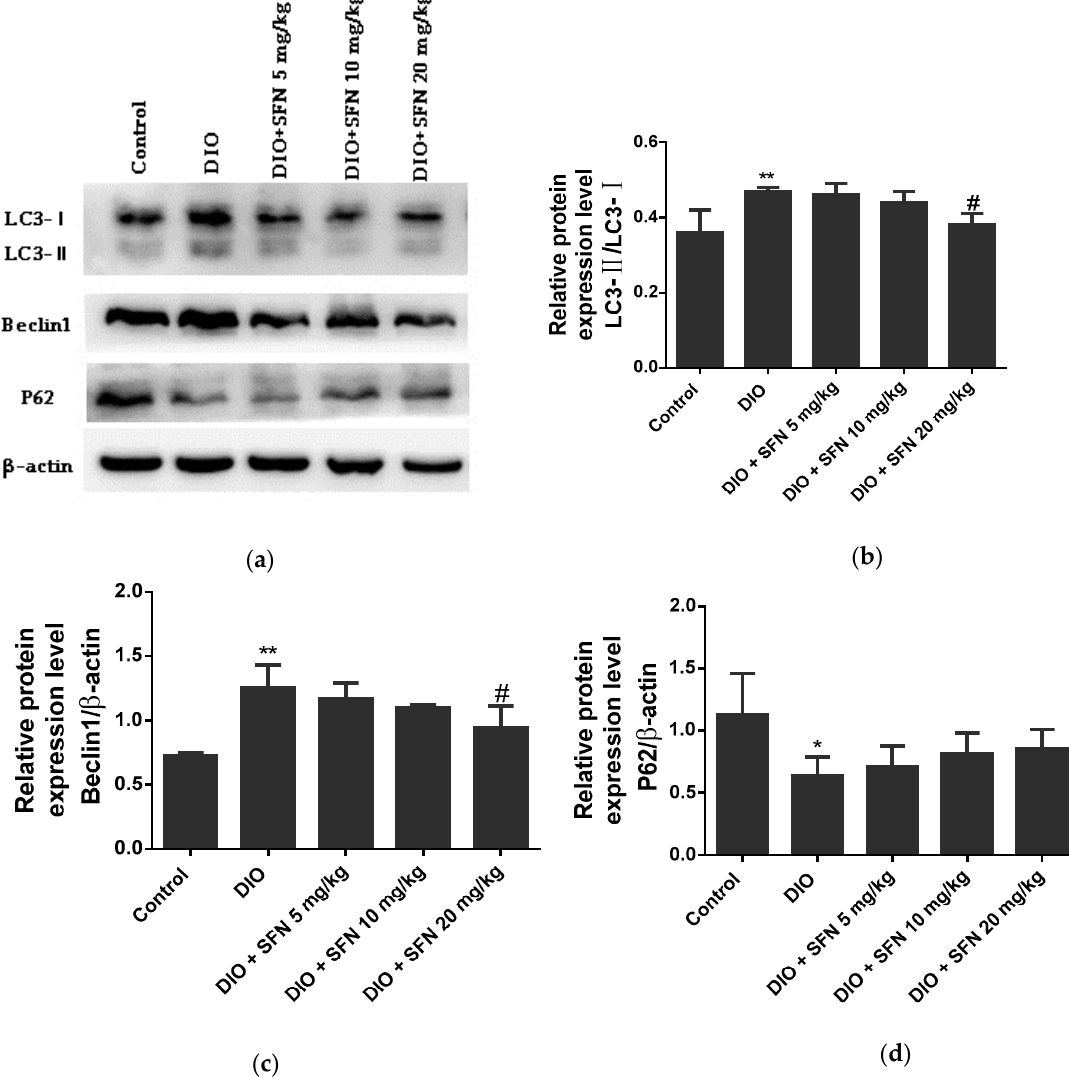
Figure 7. Effects of SFN on the protein expression related to autophagy in obese mice: ( a ) Protein expression of LC3, Beclin1, and P62. β -actin was used as a protein control to normalize the volume of protein expression: ( b – d ) Semiquantitative measurement of LC3, Beclin1, and P62. Data are expressed as mean ± SE. n = 3. * p < 0.05 and ** p < 0.01 vs. the control mice. # p < 0.05 vs. DIO mice.